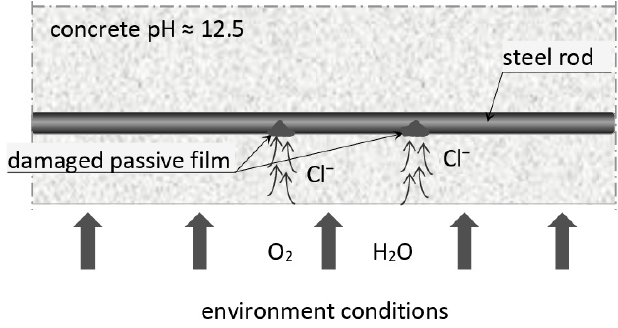
Figure 4. Reinforcement corrosion caused by the penetration of chloride ions [own study].